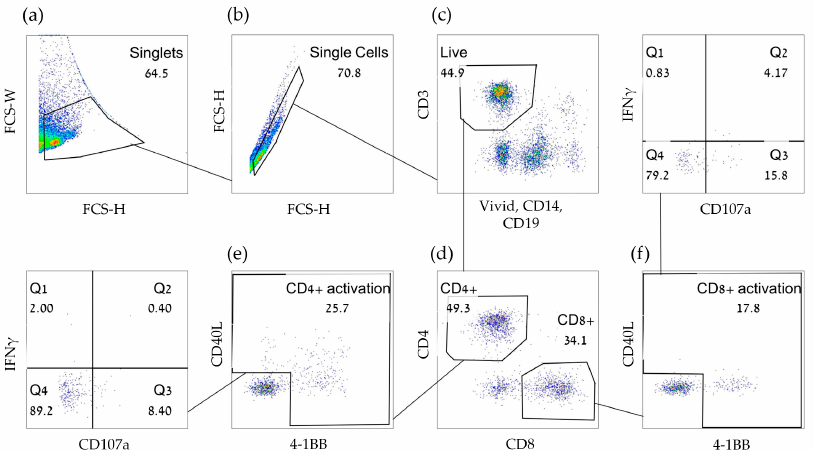
Figure 5. Full gating strategy for recently activated T cells using the Activation marker-inclusive FCM (A-FCM) . PBMC were cultured with or without peptides overnight and stained using a panel containing, among others, antibodies to 4-1BB, CD40L, IFN γ and CD107a. The cells were analyzed by FCM and serially gated for ( a , b ) Non-doublet/clumped single-cell gates. ( c ) Live CD3+ T cells which do not express CD14 or CD19. ( d ) T-helpers (CD4+) and cytotoxic T cells (CD8+). ( e , f ) T cells expressing one or more activation markers. Each population was then gated for degranulation (CD107a) and for IFN γ